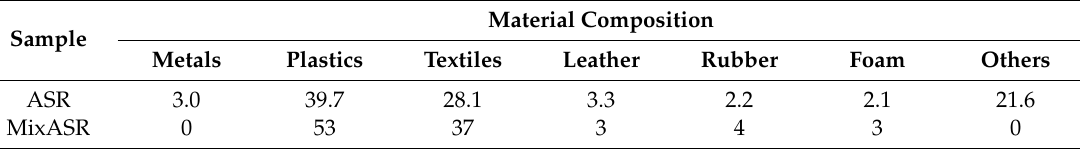
Table 1. Material compositions of the experimental specimens.